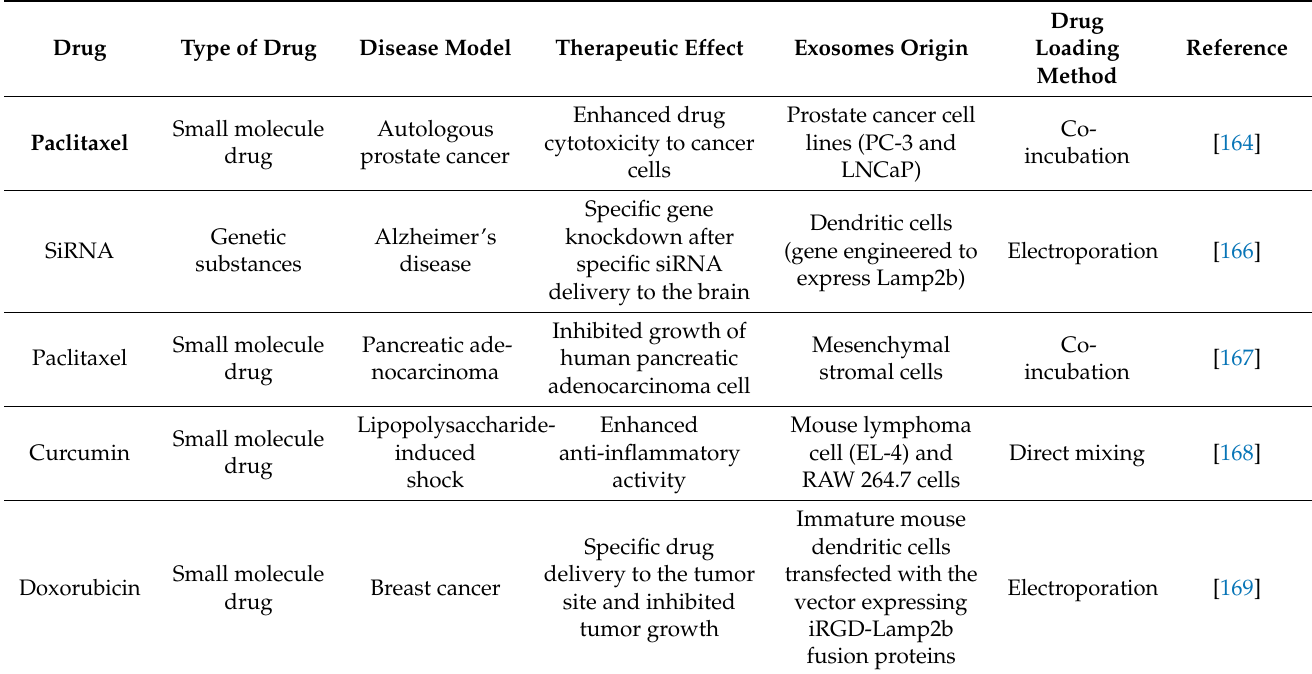
Figure 4. Therapeutic applications of exosomes in various diseases. Exosome examples in various diseases as advanced drug delivery carriers as shown in Table 5. Table 5. Use of exosomes as drug carriers in various diseases adopted with kind permission from reference